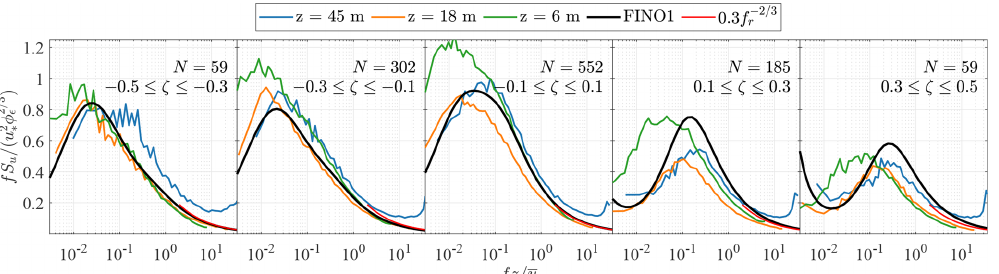
Figure B2. Normalised spectra of the along-wind component on SMW with the corrected friction velocity and five stability bins. The red curve is derived from Eq. (5), and N denotes the number of samples considered for ensemble